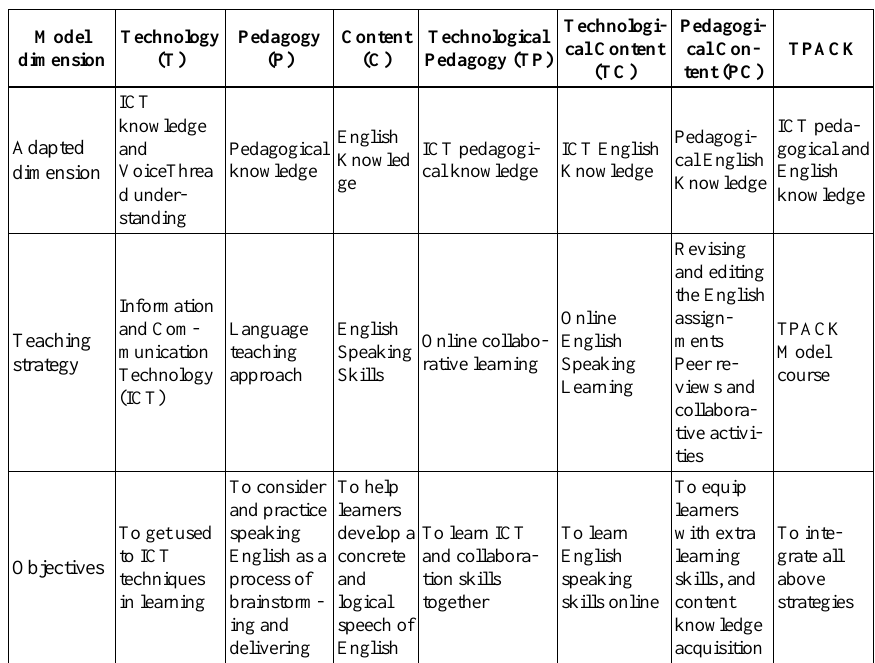
Table 3. TPACK intervention in online course